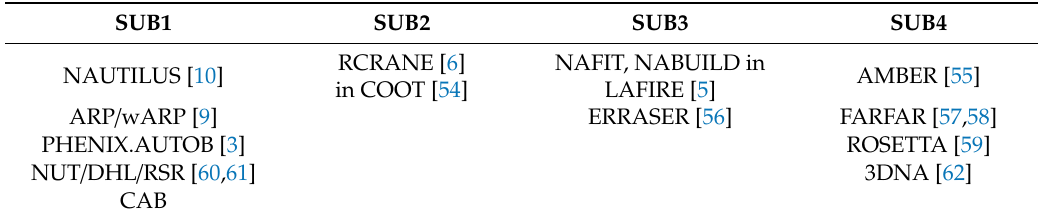
Table 5. Most popular automated or semi-automated tools for model building of nucleic acids. SUB1: automated model building into electron density map from sequence; SUB2: guided semi-automated model building into electron density maps; SUB3: completing and rebuilding existing models into electron density maps; SUB4: building models from sequences without electron